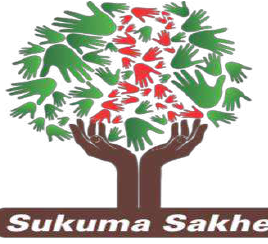
Fig. 1. Sukuma Sakhe symbols and